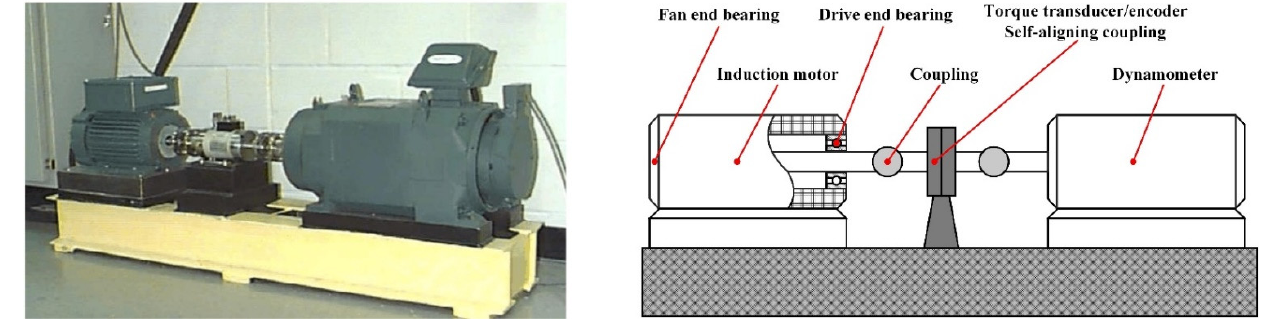
Figure 4. Rolling bearing fault simulation experimental device.